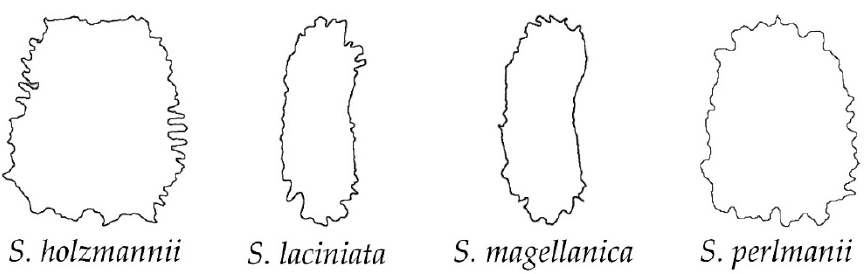
Figure 8. Silhouettes of the dorsal view of seeds in the group of papillose outline.